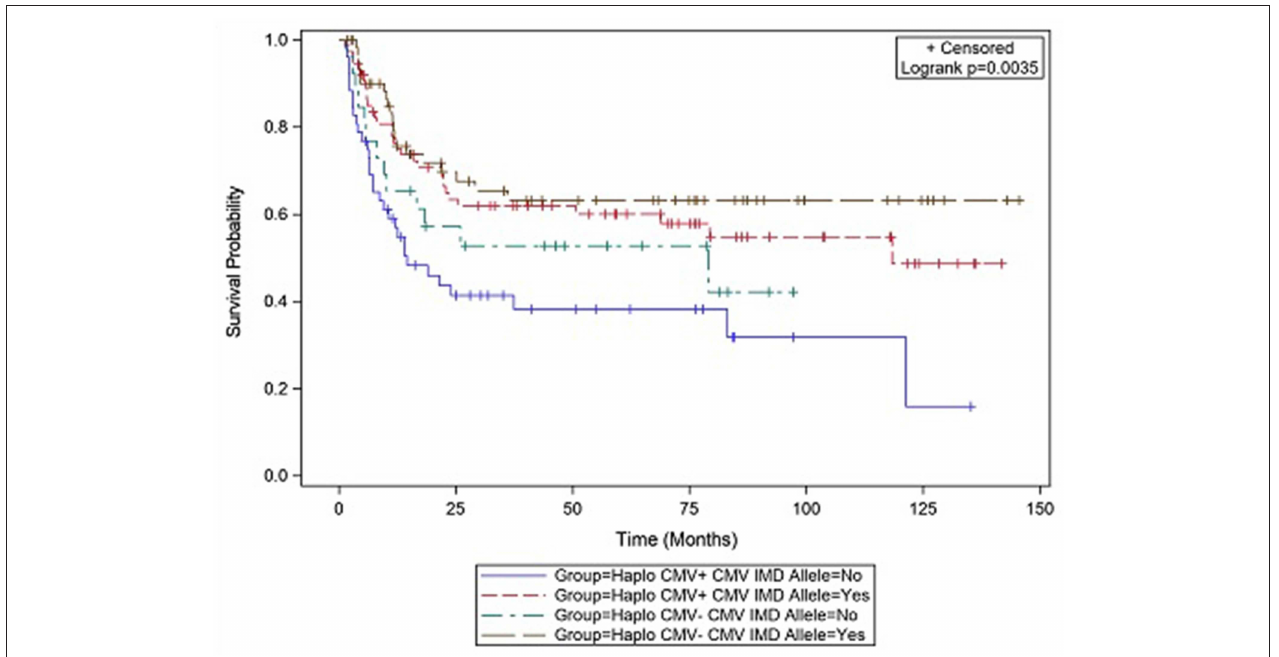
FIGURE 3 | Survival differences in CMV + vs. CMV– patients based on the presence or absence of a CMV immunodominant allele.